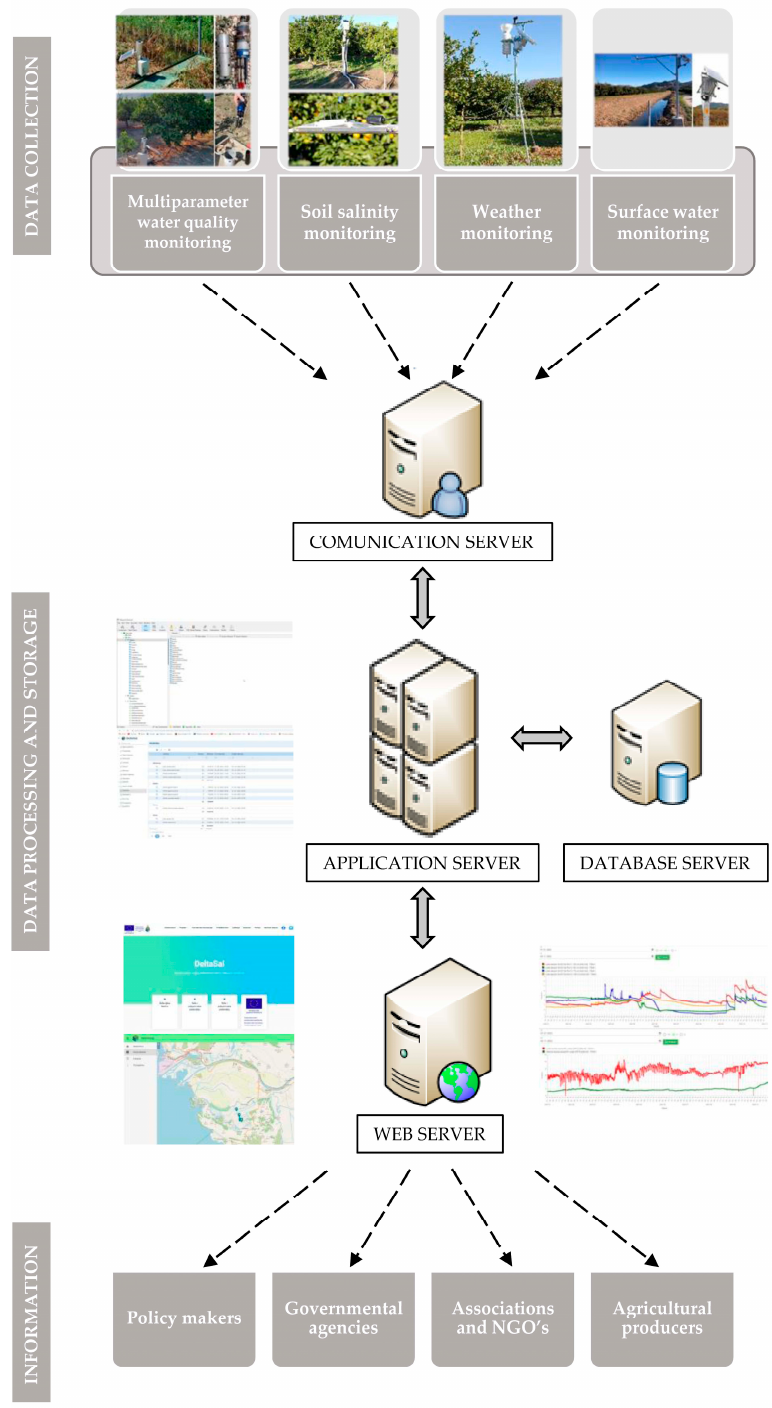
Figure 3. Scheme of DELTASAL ACMS.